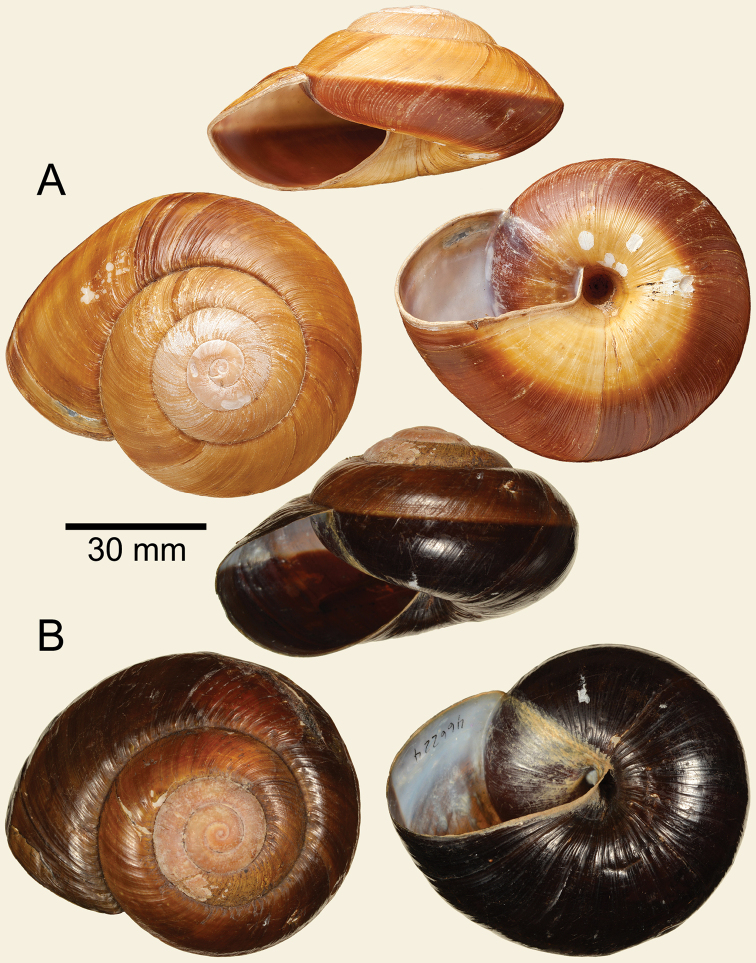
ABertia
pergrandis, syntype NHMUK 1893.2.26.1 BBertia
setzeri, holotype ANSP 466244.